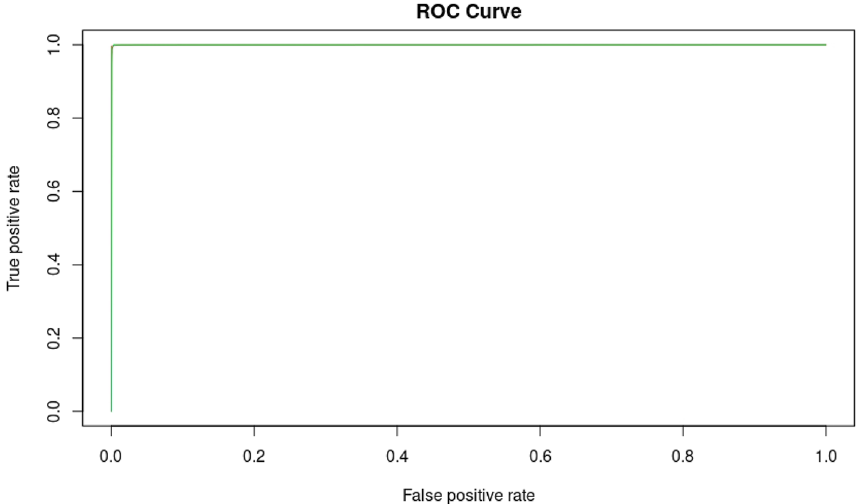
Figure 3. ROC curve for the validation set. Thirty cross-validations were assessed using 7 functional features: chromosome (Chr), position (POS), exon, variant allele frequency (Freq), minor allele frequency (MAF), coverage and amino acid change (protdesc) for the model machine learning random forest (MLRF) for oncosomatic variants. Model performance was evaluated using the receiver operating characteristic (ROC) curve. The area under the curve is denoted AUC. AUC obtained was 0.99. A large area under the curve was observed. The model could then determine whether a variant was benign or pathogenic with a minimal error